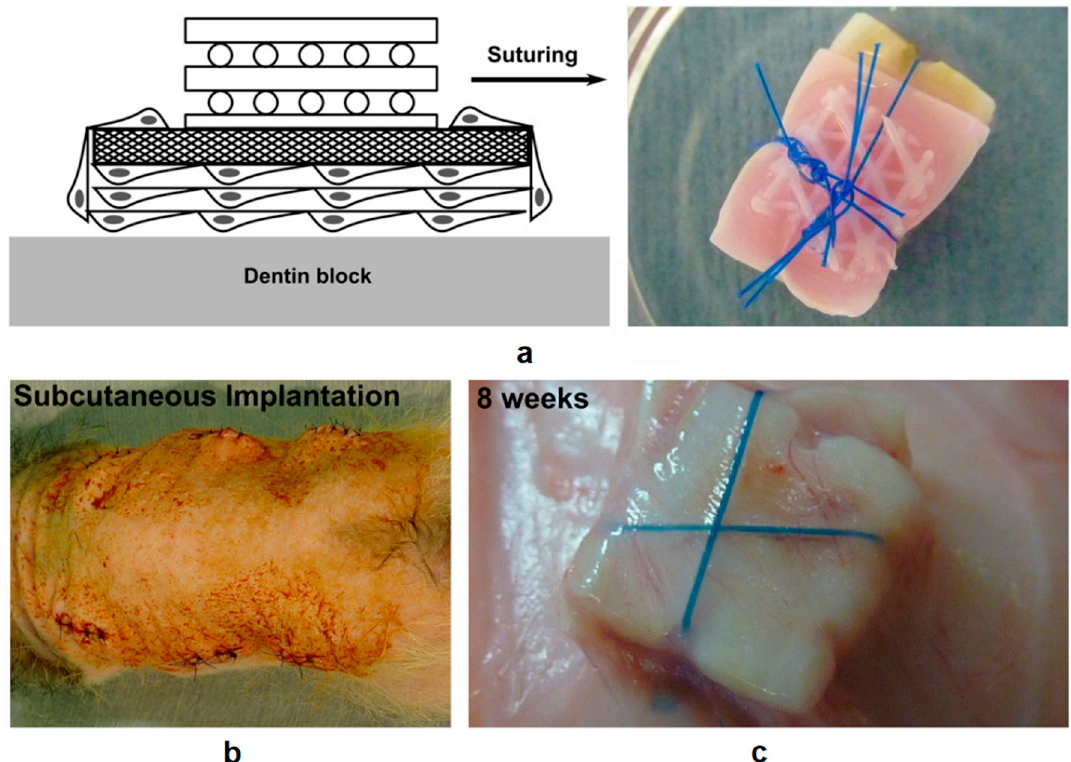
Figure 3. ( a ) Demonstration of the assembling a biphasic scaffold onto a dentin block. The blue cords are surgical sutures used to fix scaffolds together with the dentin block. ( b ) Illustration